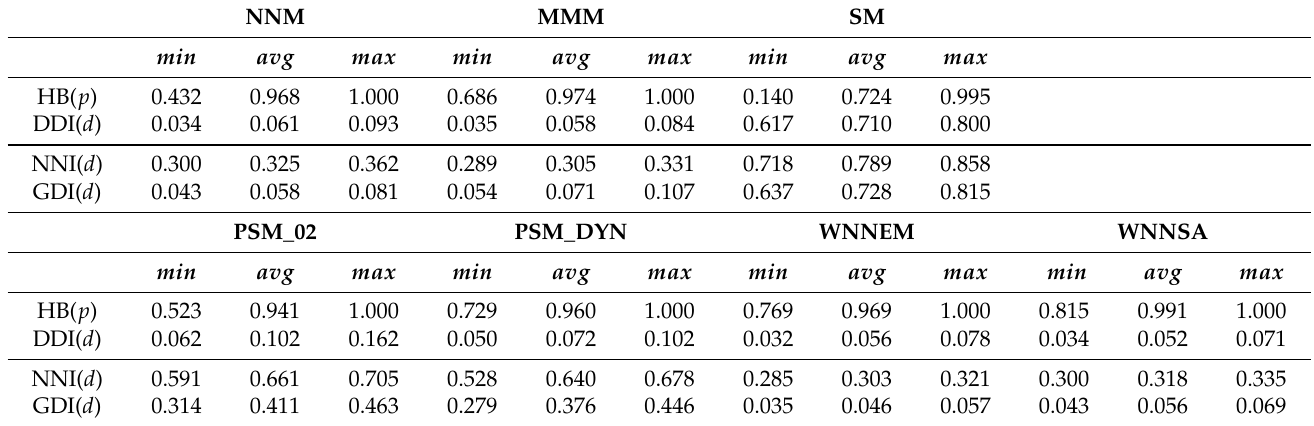
Table 2. Measures for evaluating the group-level similarities of case and control groups in Scenario II. HB( p ) denotes the p -value of the Hansen and Bowers test, DDI( d ) represents the dissimilarity value of the Distribution Dissimilarity Index, NNI( d ) stands for the dissimilarity value of the Nearest Neighbour Index, and GDI( d ) is the dissimilarity value of the Global Dissimilarity Index. In the case of HB( p ), the higher value is better, while in the case of DDI( d ), NNI( d ) and GDI( d ), the lower value is